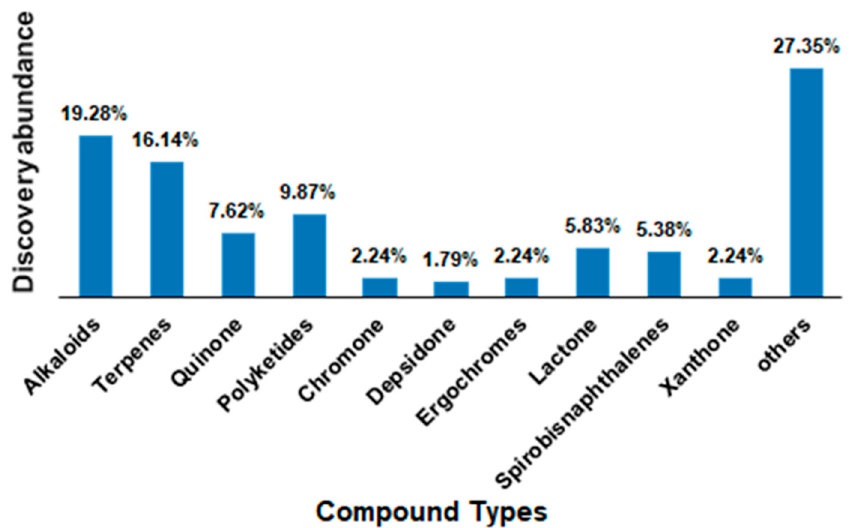
Figure 2. Relative abundance of anticancer agents from endophytic fungi.